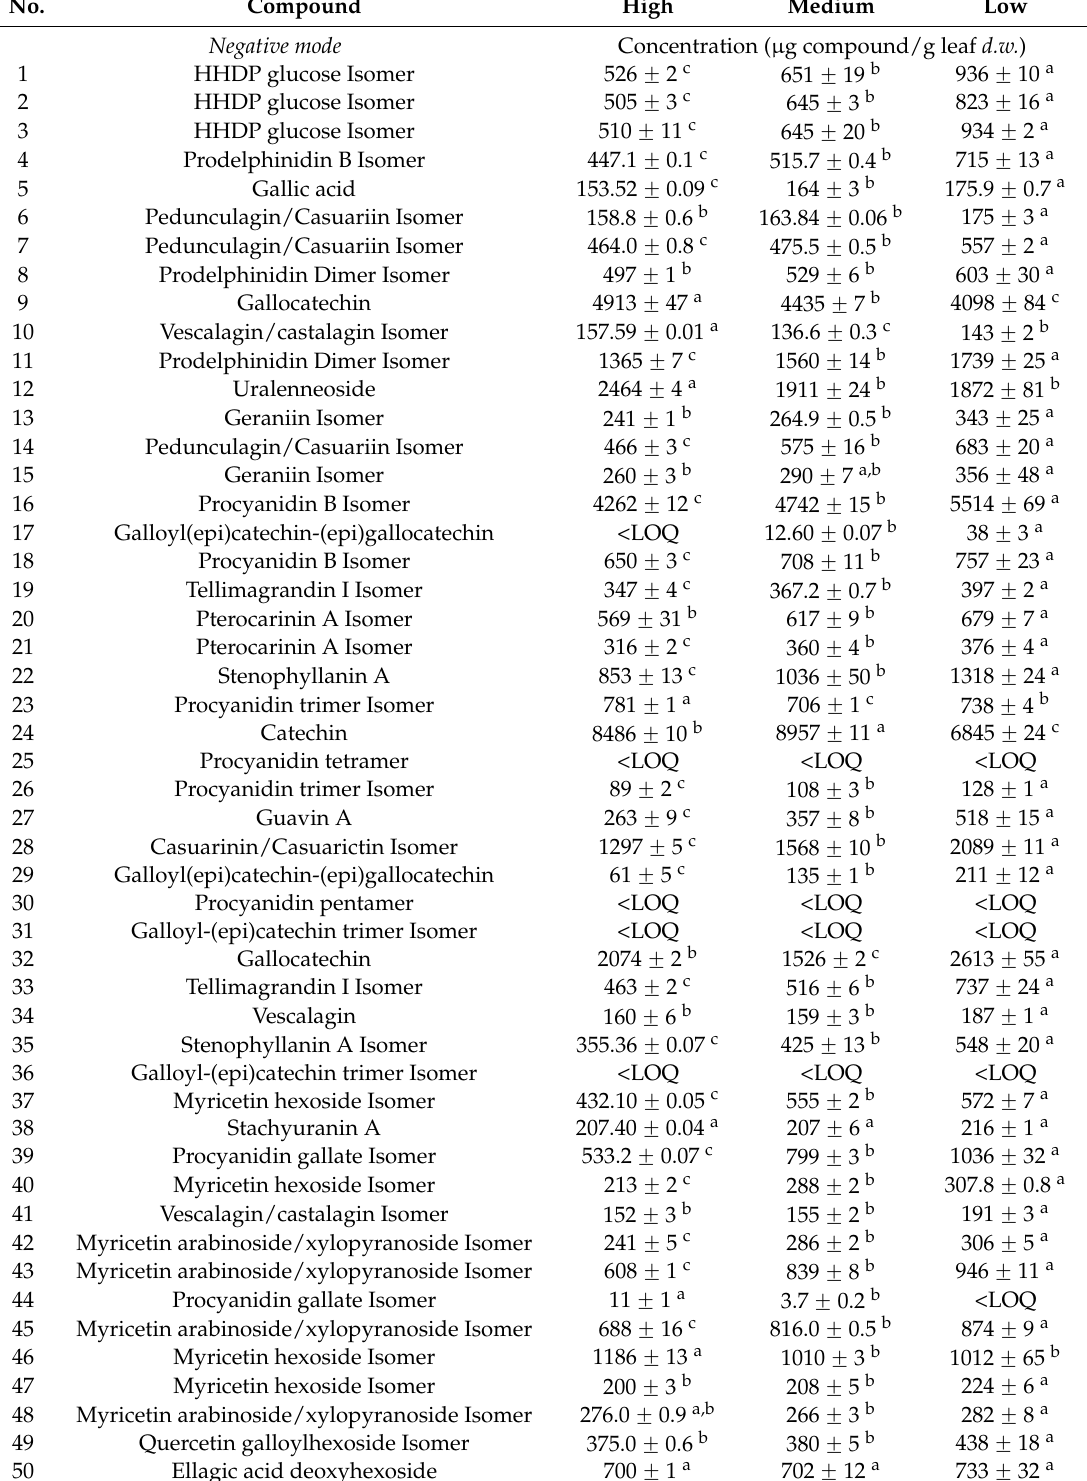
Table 1. Quantification (mean ˘ standard deviation (SD), n = 3) by HPLC-DAD-ESI-QTOF-MS in negative and positive mode of individual compound tentatively identified in P. guajava leaves for the different oxidative